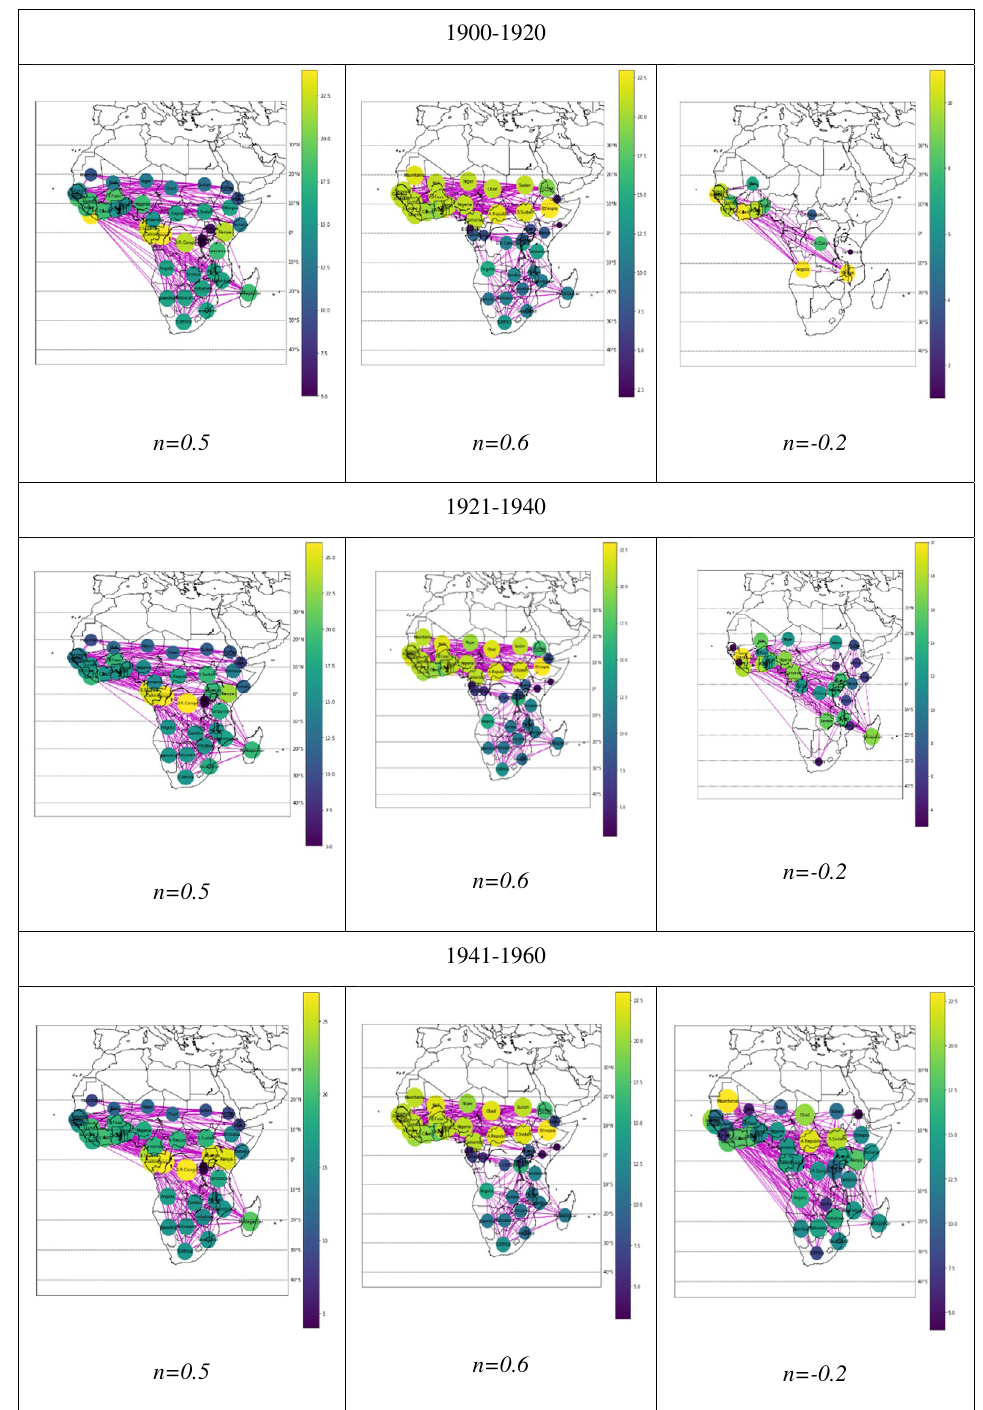
Figure 1. Networks connecting nodes with cross-correlation coefficients greater than the threshold